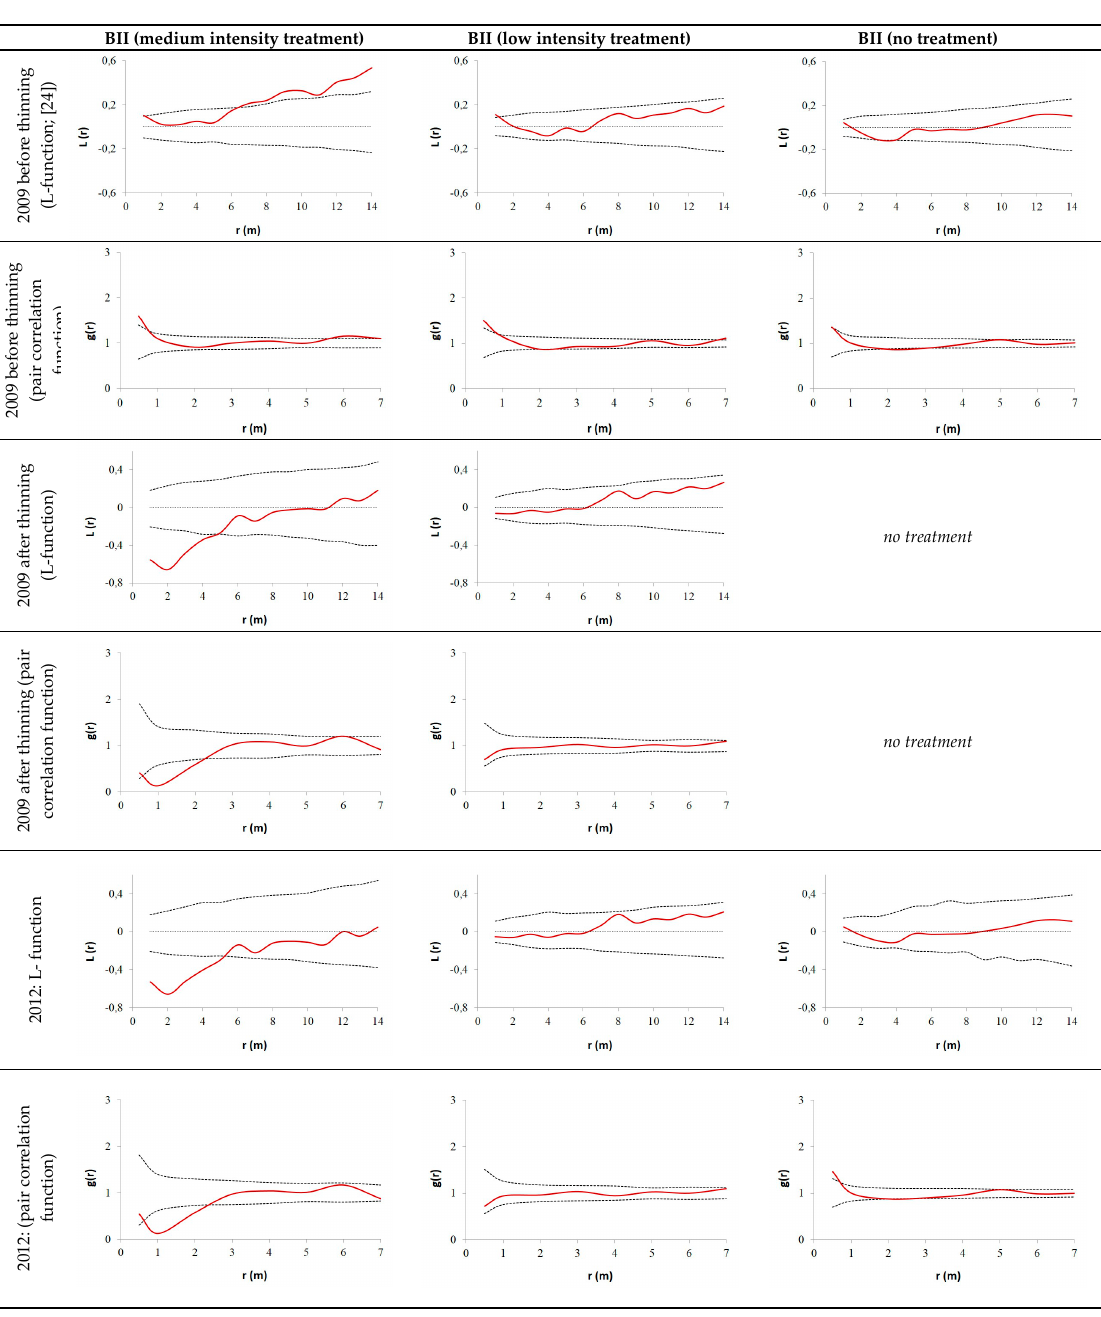
Figure 4. L-function and pair correlation function of the plots in stand BII before and after thinning in 2009 and at the end of the observation period in 2012.